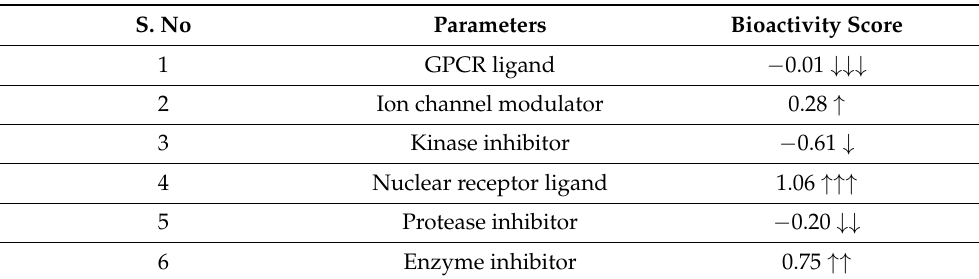
The upward arrow represents high bioactivity while downward arrow is showing low bioactivity of